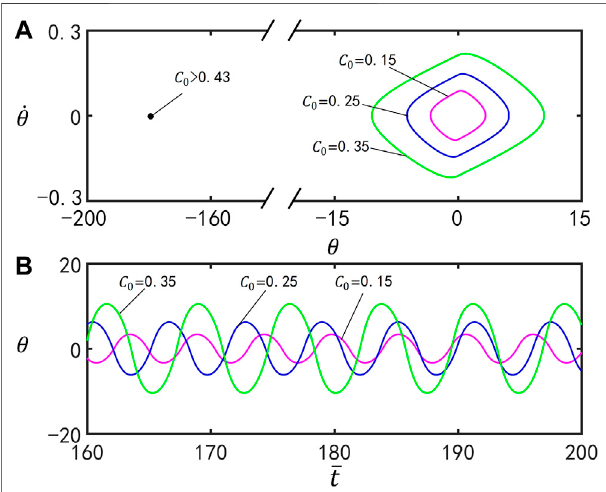
FIGURE 7 | Effect of the contraction coef fi cient C 0 on self-stabilized oscillation of the inverted pendulum for (cid:2) I (cid:2) 0 . 6, (cid:2) g (cid:2) 9 . 8, (cid:2) ζ (cid:2) 14 . 7, θ 0 (cid:2) 0 ° , θ (cid:2) 70 ° ,and _ θ (cid:2) 0. (A) Limitcyclesfor C 1 0 (B) Time series for C 0 (cid:2) 0 . 15, C 0 (cid:2) 0 . 25, and C 0 (cid:2) 0 . 35. The amplitude and period of self-stabilized oscillation increase by increasing C 0